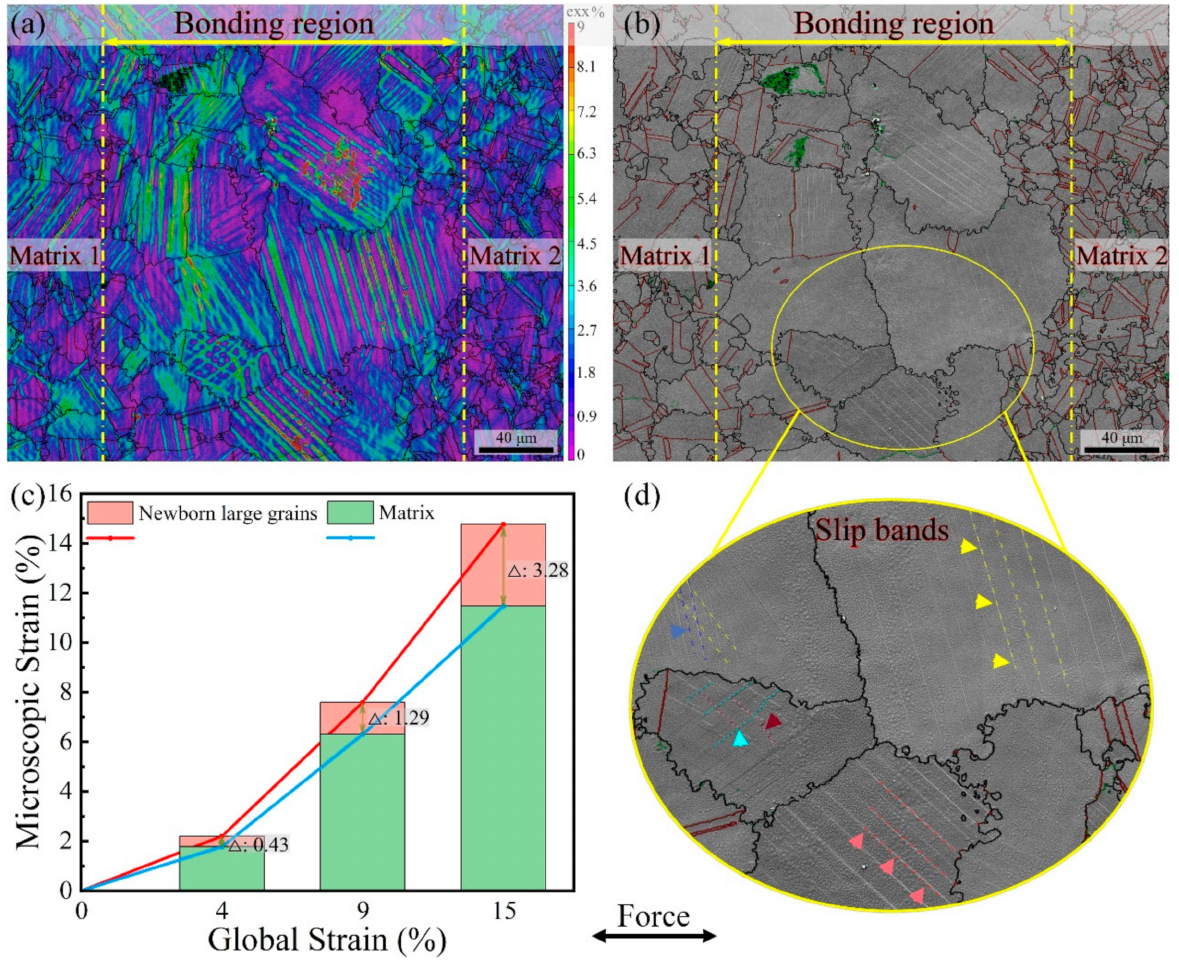
Figure 6. The microscopic strain distribution at 4% global strain by SEM-DIC ( a ), and the SEM images ( b ) with a higher magnification ( d ). The microscopic strain discrepancy between the bonding region and the neighboring matrix region with increased global strain ( c